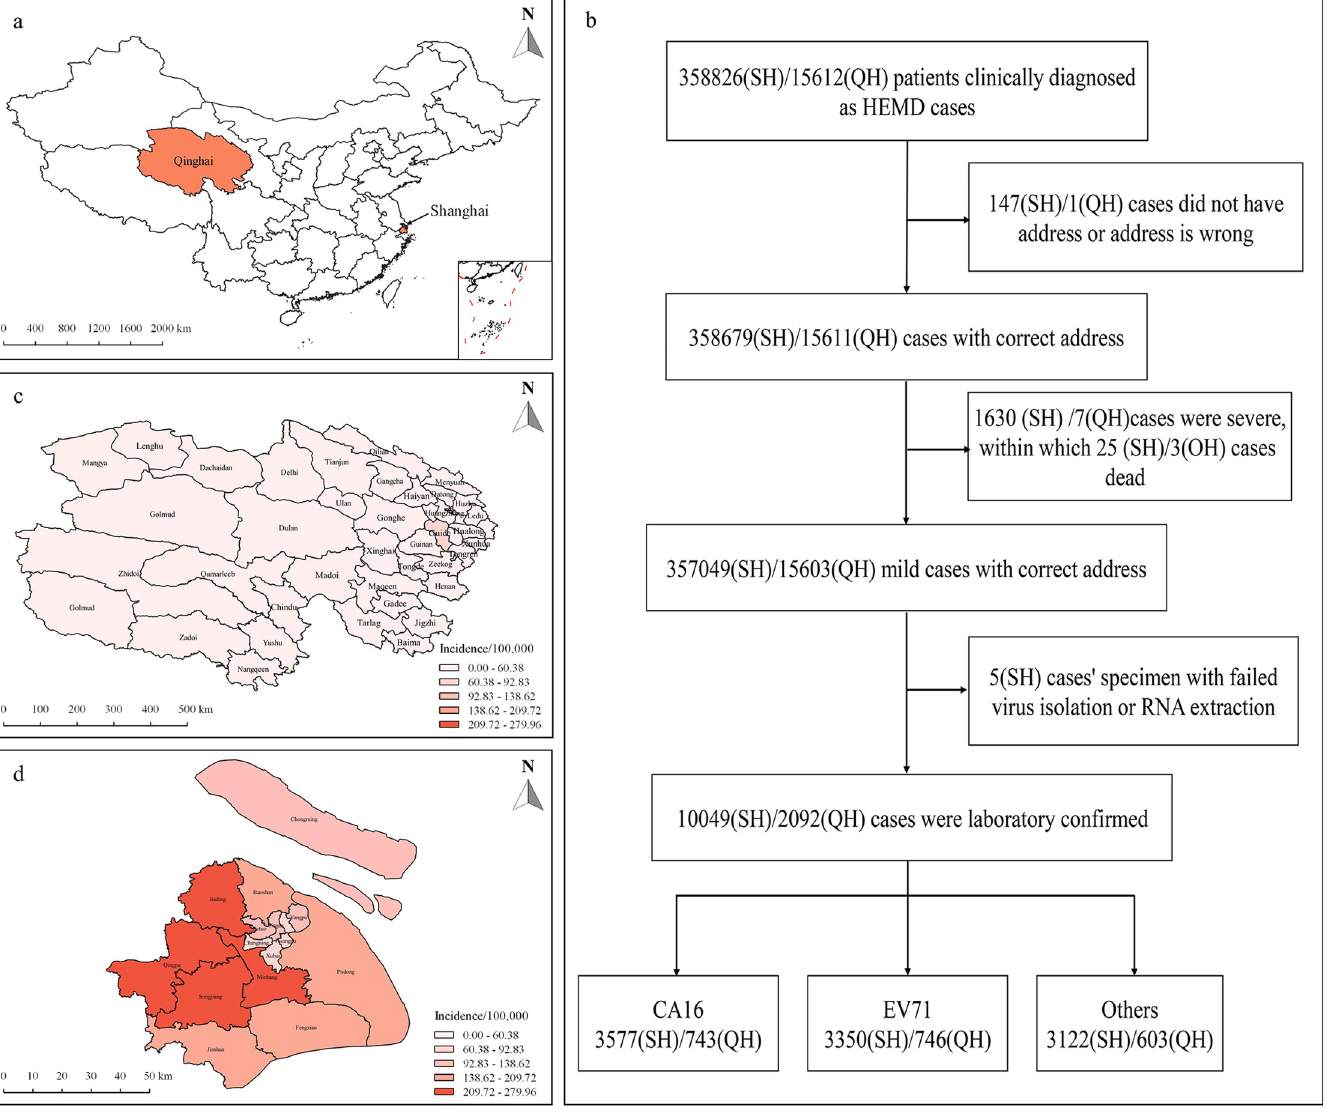
Fig 1. a. Classification of HFMD based on treatment history and laboratory analysis. b, Location of Qinghai Province and Shanghai Municipality, China. c/d, Annual average incidence of HFMD in Qinghai/Shanghai. SH = Shanghai; QH = Qinghai. The map a, c, and d were created using ArcGIS software (version 10.4.1, ESRI Inc. Redlands,